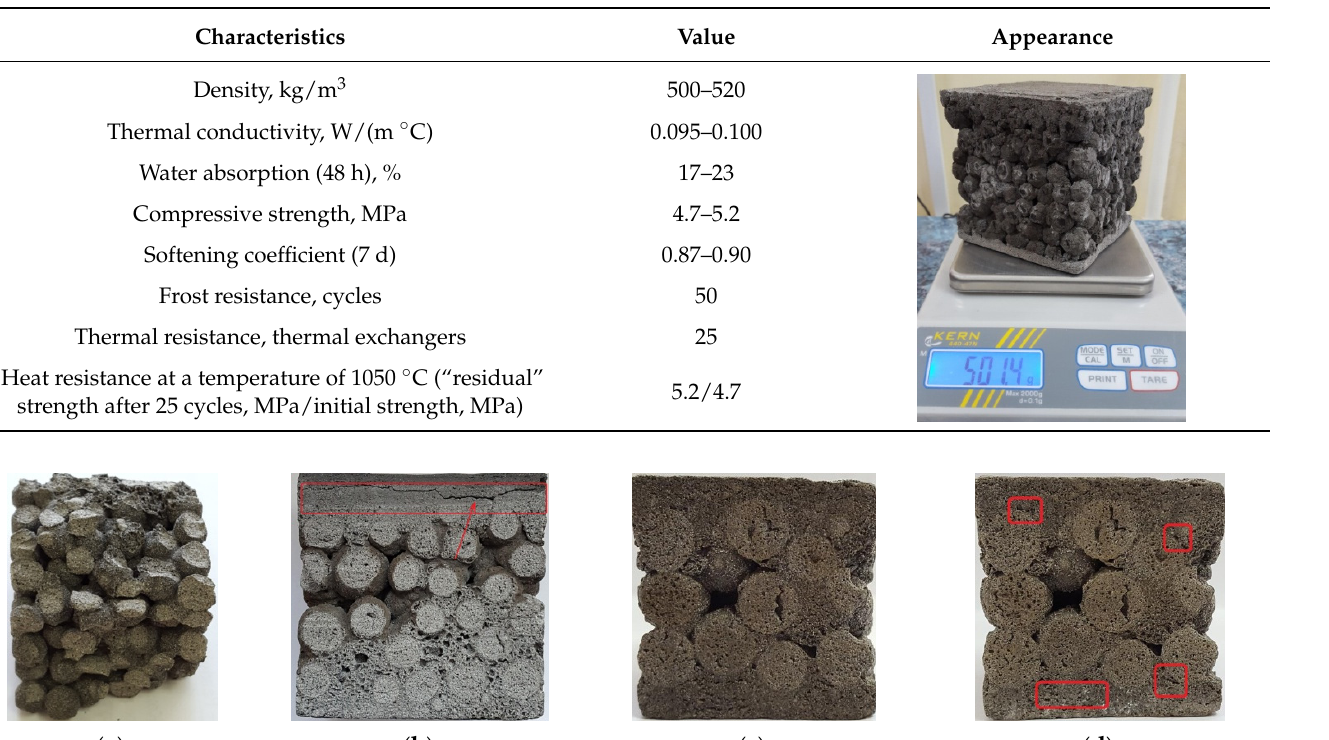
Table 9. Main characteristics of the composite material (C f = 0.43).